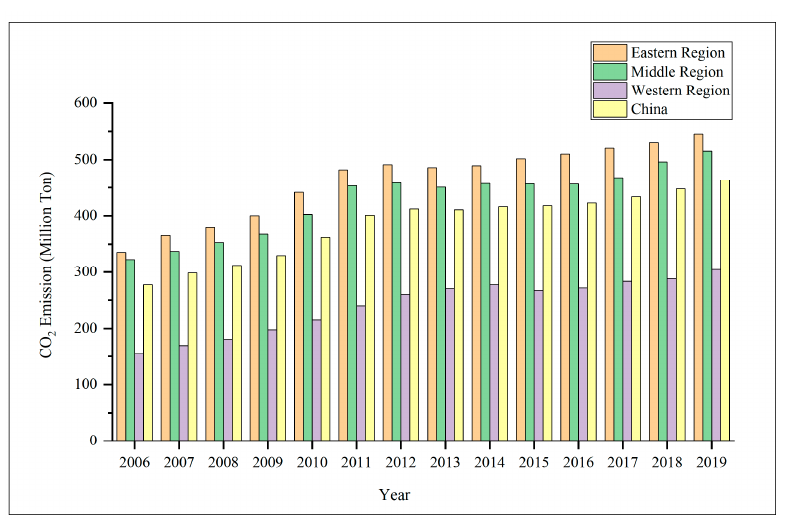
Figure 2. Averages of CO 2 emissions in three main regions in China from 2006 to 2019. At the regional scale, the average CO 2 emissions of the eastern, central, and western regions were 334.95 million tons, 322.68 million tons, and 155.49 million tons, respectively, in 2006. The average CO 2 emissions of the eastern, middle, and western regions increased to 535.34 million tons, 515.03 million tons, and 304.43 million tons in 2019, with annual growth rates of 3.82, 3.66, and 5.30%, respectively. The order of mean CO 2 emission is eastern region > central region > western region (Figure 2). At the provincial scale, CO 2 emissions in nine provinces were higher than the national average of CO 2 emissions (277.43 million tons) in 2006, and CO 2 emissions in 11 provinces were more than the national average of CO 2 emissions (463.97 million tons) in 2019. Shandong province has always ranked first in CO 2 emissions in China, whereas Qinghai province always ranked last from 2006 to 2019. The growth rate of CO 2 emission in Beijing decreased year by year, showing a negative growth rate. The growth rate of CO 2 emissions in Shanghai and Henan remained at relatively low levels, 0.69 and 1.31%, respectively, while the growth rates for Ningxia and Xinjiang, although they were located in the western region, were 10.82 and 10.05%, respectively (see Figure 3). Figure 3. CO 2 emissions for 30 provinces in China from 2006 to 2019.